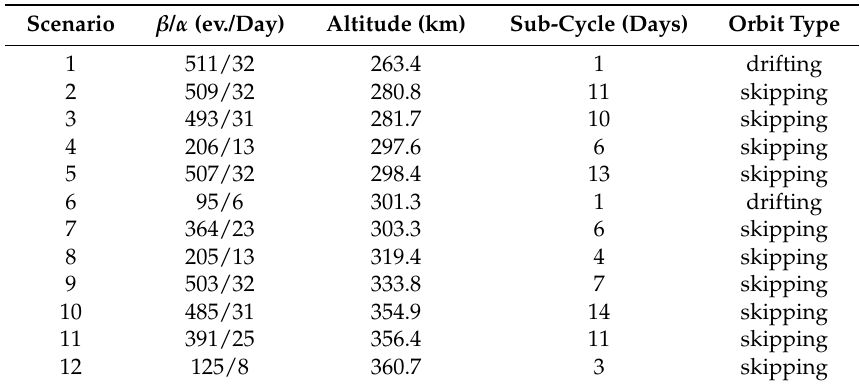
Table 1. Satellite mission scenarios of this paper